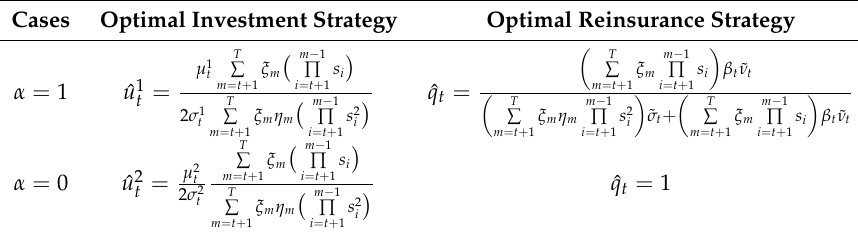
Table 2. Optimal strategy when the variance value premium principle and unilateral interests are considered. Cases Optimal Investment